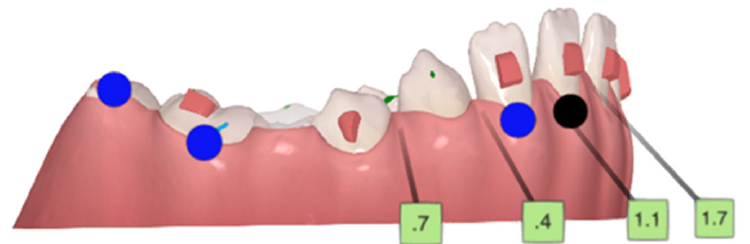
Figure 6. Initial curve of Spee, with eruption compensation on tooth 45. Blue dots—moderate movements; black dots—complex movements.